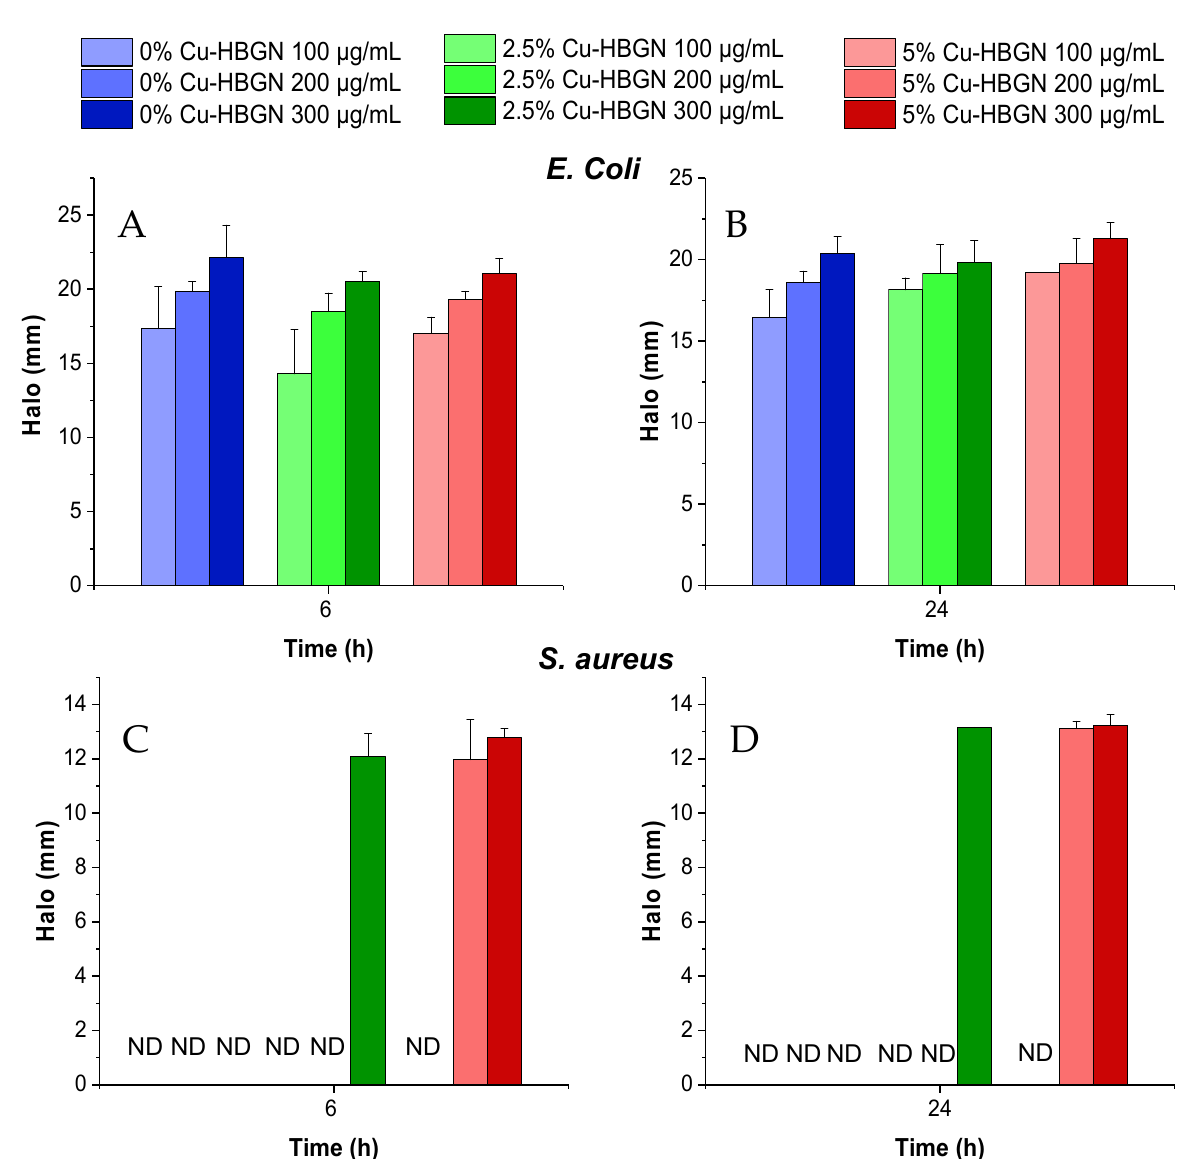
Figure 9. Inhibition halos obtained from the contact of HBGN loaded with danofloxacin, at different concentrations, times, and bacterial species: ( A ) E. coli at 6 h, ( B ) E. coli at 24 h, ( C ) S. aureus at 6 h and ( D ) S. aureus at 24 h. Non-detected halos are marked as ND.